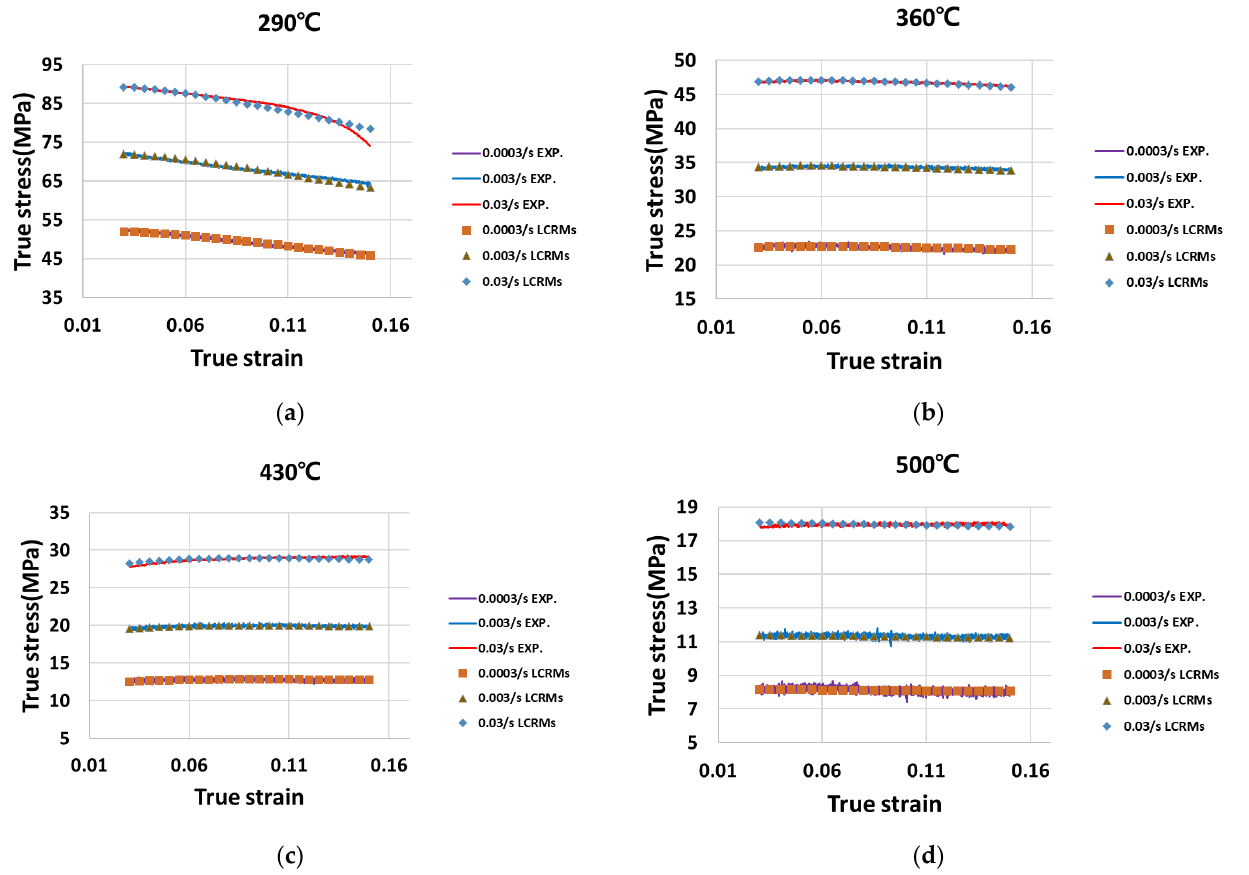
Figure 7. True stress–strain curves by LCRMs at ( a ) 290 °C, ( b ) 360 °C, ( c ) 430 °C, and ( d ) 500 °C.